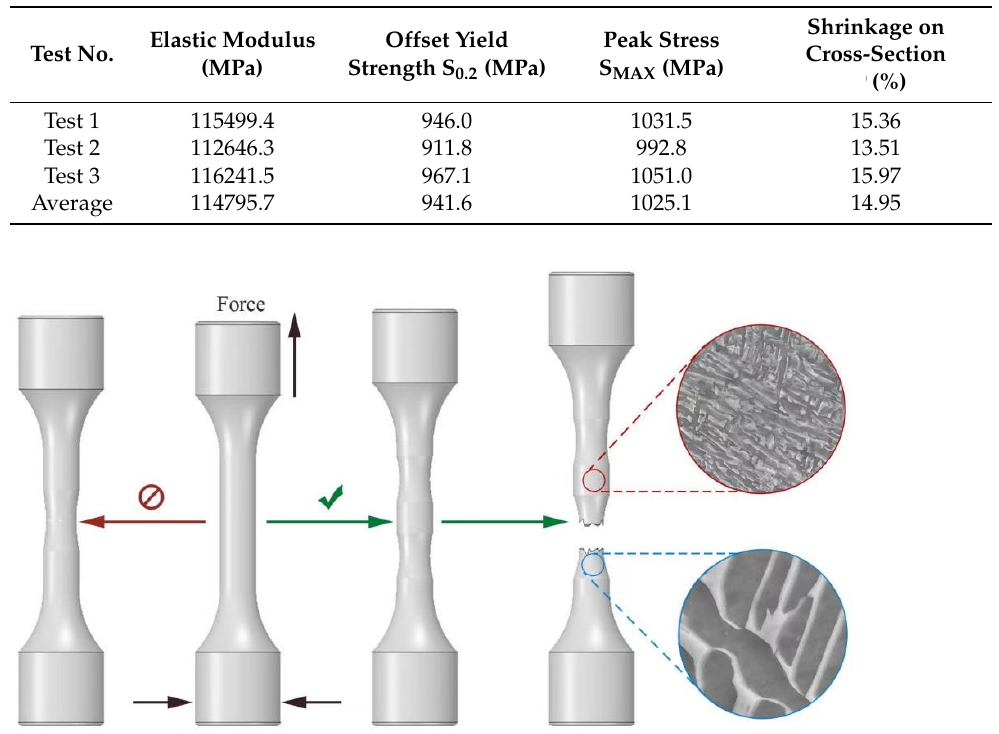
Table 2. Parameters obtained from the tensile tests of IFW joints of TC21 alloy.